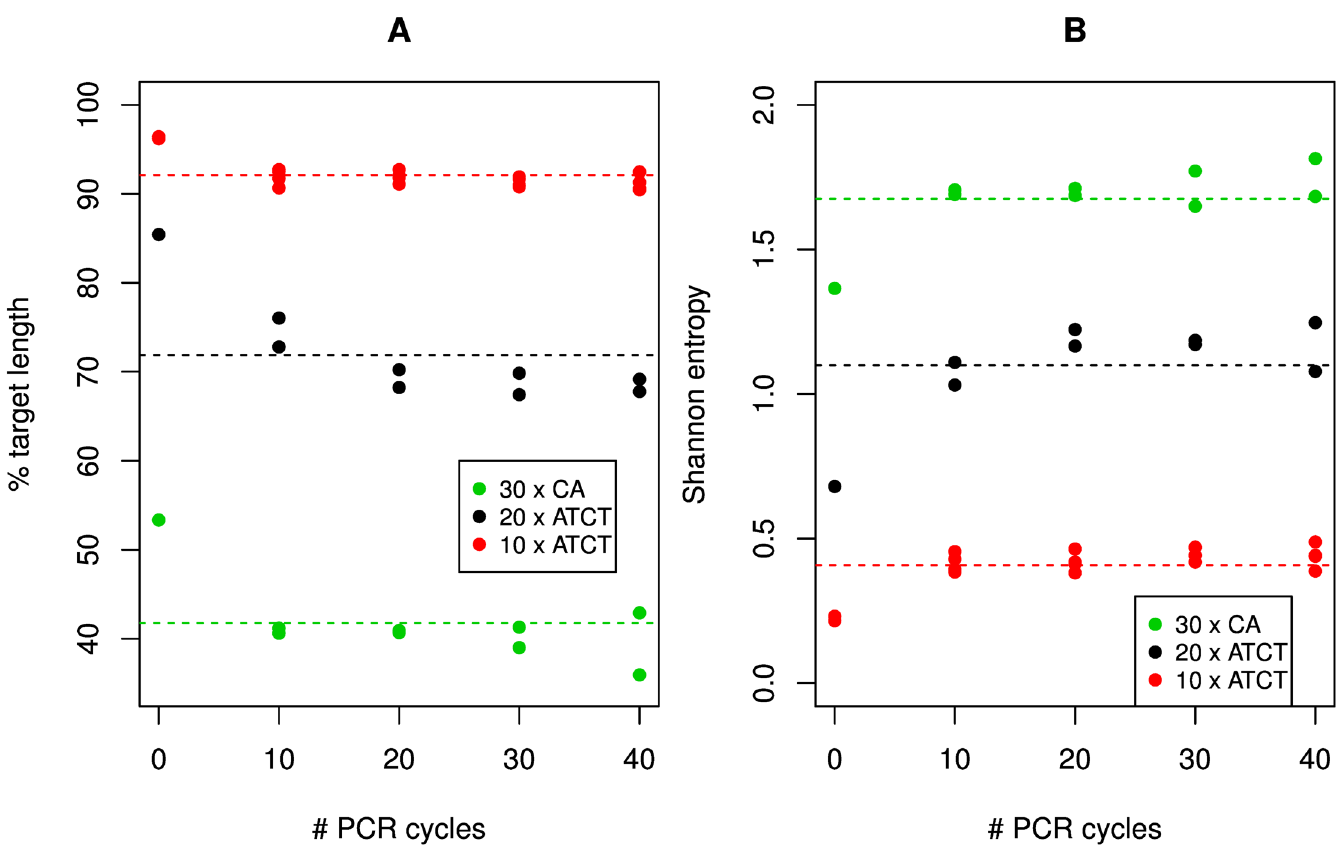
Fig 4. Microsatellite length scoring accuracy. A. Percentage of reads matching the expected sequence length. B. Shannon entropy of measured microsatellite lengths in each experiment. The plotted values are based on both stepwise and non-stepwise